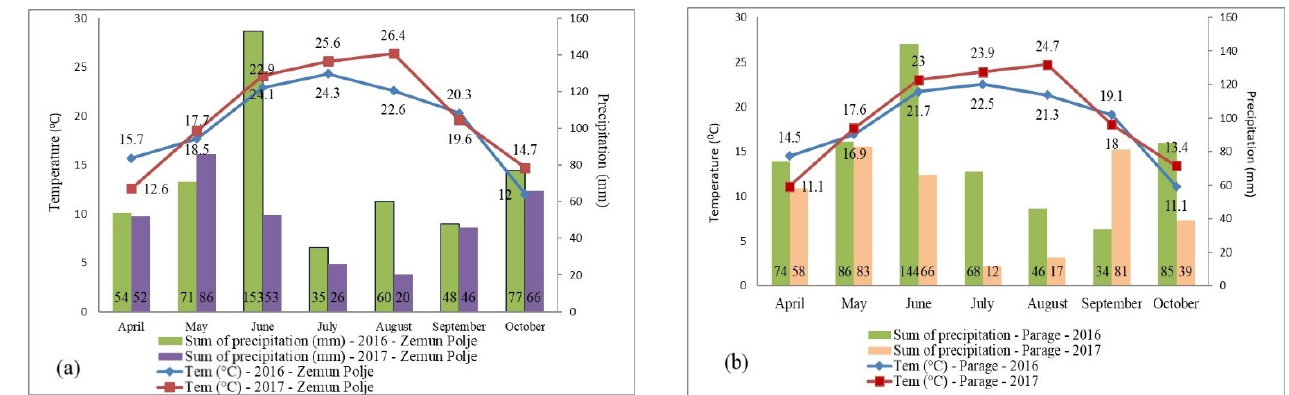
Figure 1. ( a ) Temperature and precipitation data in 2016 (Y1) and 2017 (Y2) in the location of Zemun Polje (L1); ( b ) Temperature and precipitation data in 2016 (Y1) and 2017 (Y2) in location of Parage (L2). Table 4. Average yield (kg/ha) of three maize inbreed lines grown in four year–location interactions in two densities for five defoliation treatments.